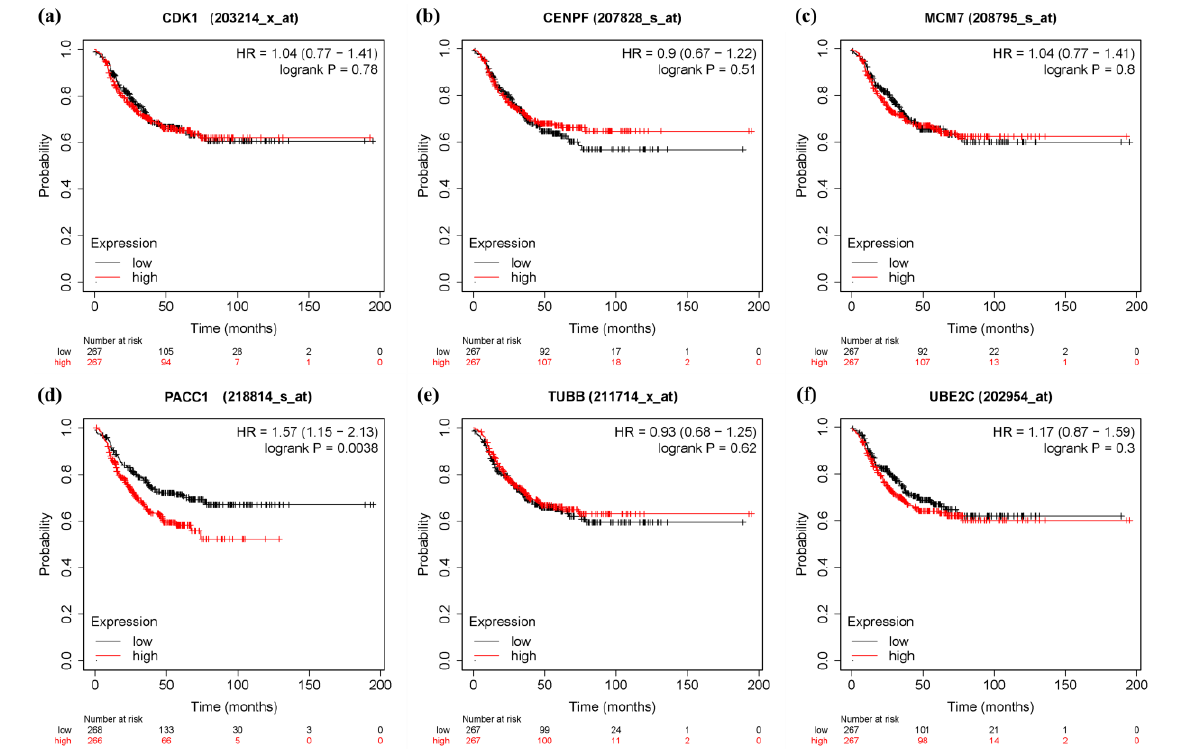
Figure 13. Disease free survival (DFS) analysis of 6 Significant genes in TNBC patients by KM Plotter. ( n = 534) ( a ) CDK1 ( b ) CENPF ( c ) MCM7 ( d ) PACC1 ( e ) TUBB ( f ) UBE2C.